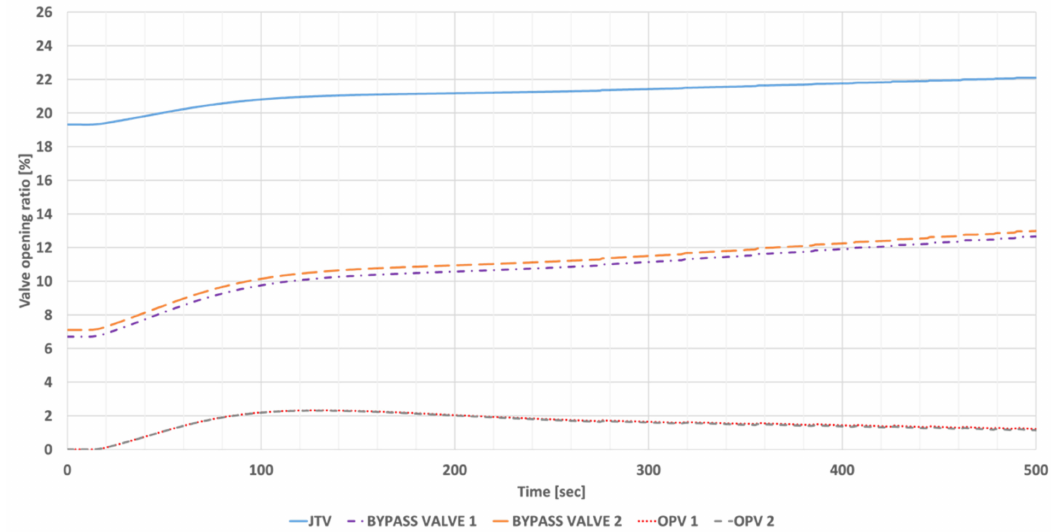
Figure 12. Valve opening ratio when two engines are tripped.